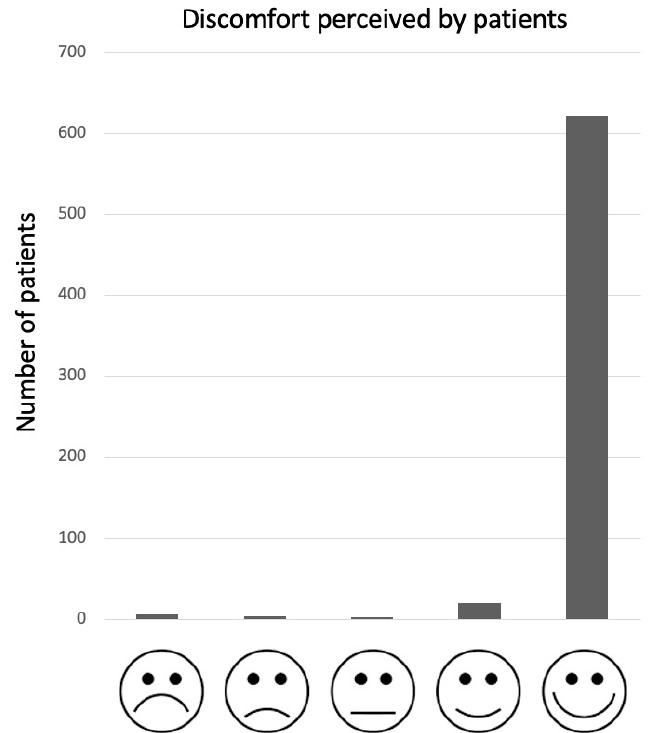
Figure 2. Acceptability of pGALS about discomfort perceived (on the Likert scale).